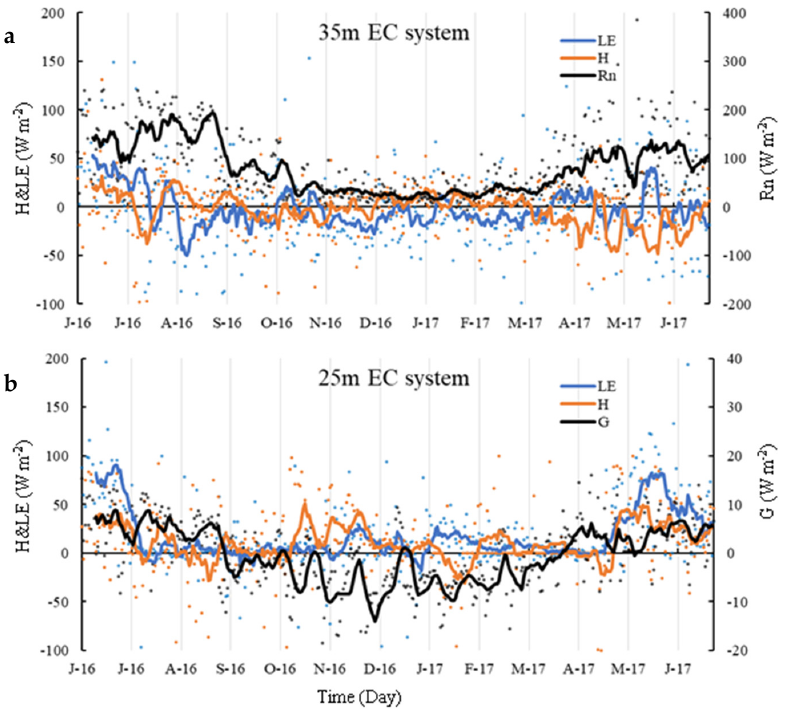
Figure 6. Characteristics of annual energy flux changes in ( a ) 35m; ( b ) 25m EC system. H represents sensible heat flux; LE represents latent heat flux; RN represents net radiation; G represents soil heat flux.